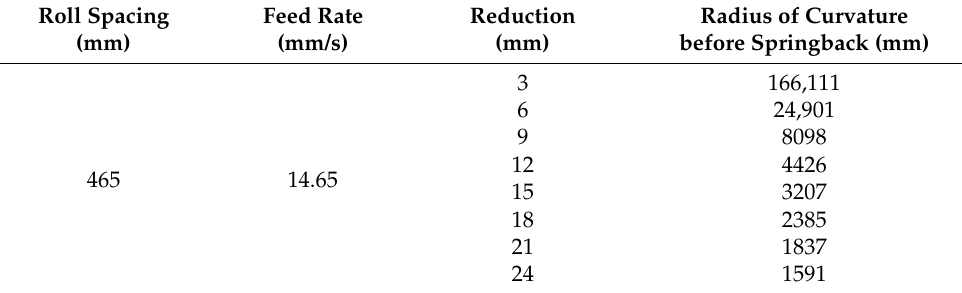
Table 1. Part of the